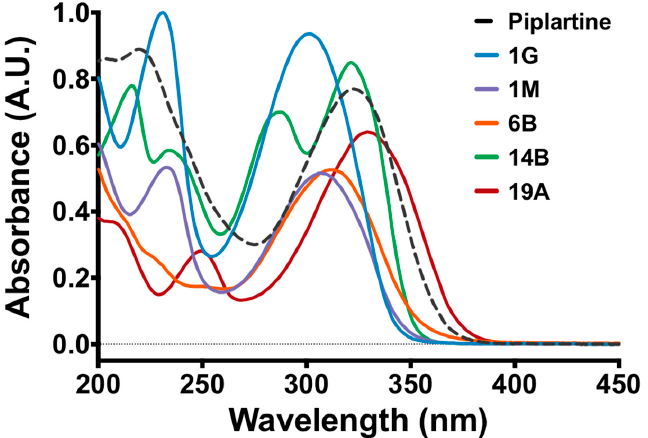
Figure 2. Ultraviolet and visible light absorption spectra of piplartine and its analogues in arbitrary units (A.U.).